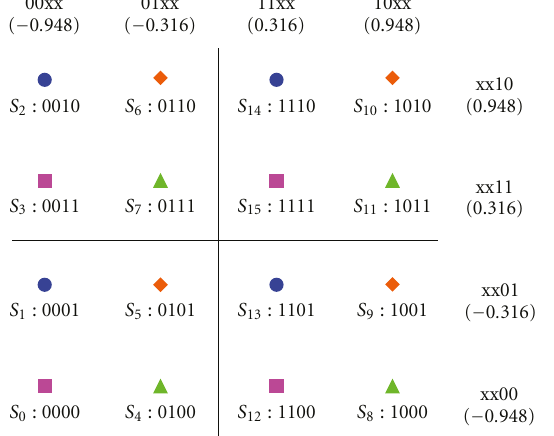
Table 3: Some bit mapping